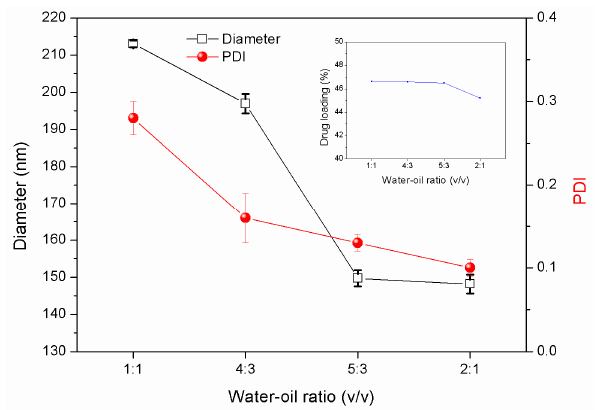
Figure 4. Particle size, size distributions, and LC loading capacities of PLA nanoparticles prepared under different water–oil ratios (PVA concentration was 2%, PLA concentration was 133 g/L, and LC-PLA ratio was 1:1).